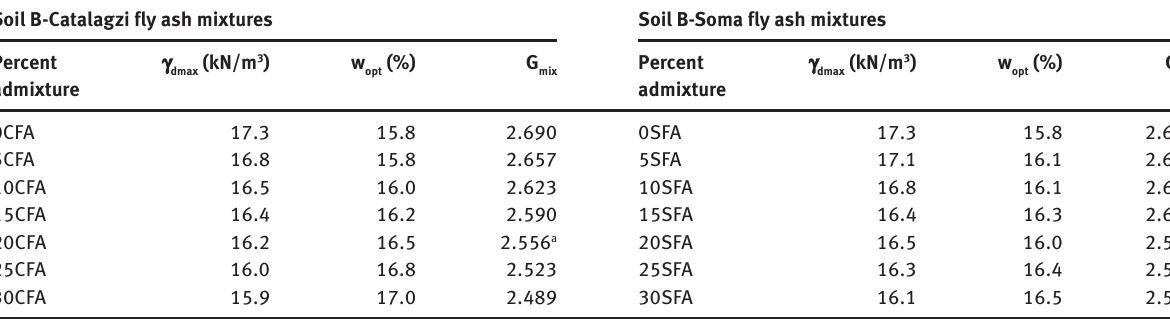
Table 6: Compaction characteristics of Soil B-fly ash mixtures. Soil B-Catalagzi fly ash